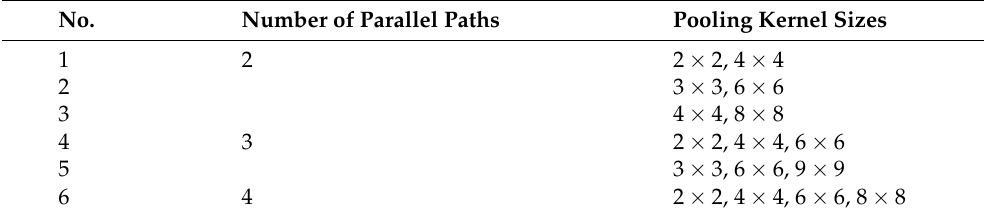
Table 3. SPP module